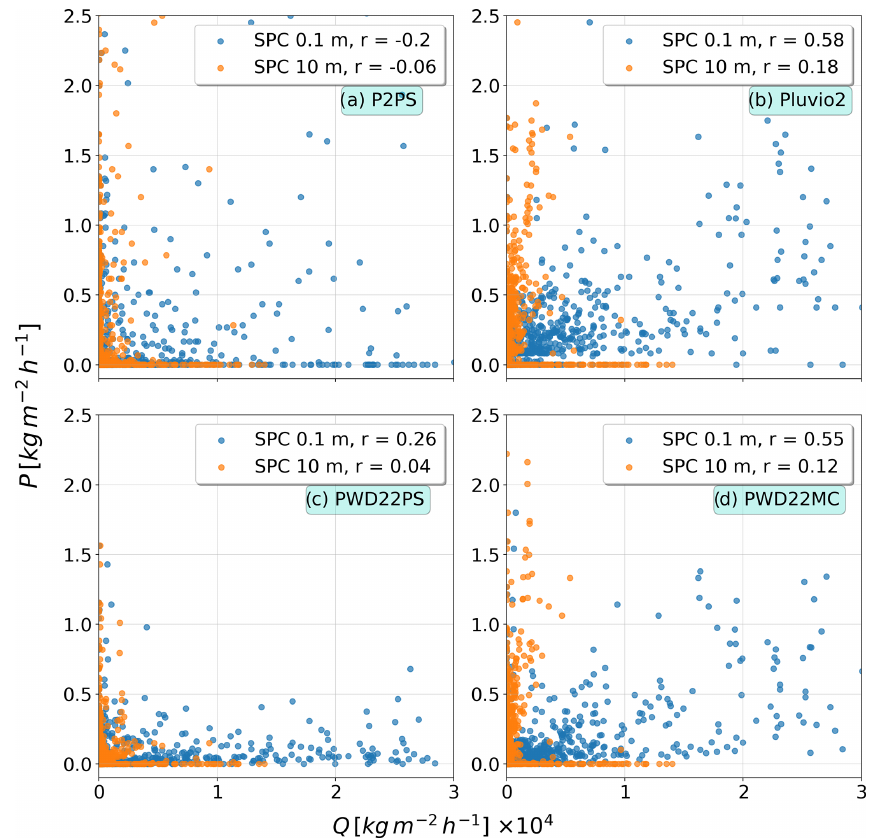
Figure 15. Scatter plots of sensor-computed snowfall rates ( y axes) vs. SPC mass flux ( x axes) for the whole time period for (a) P2PS, (b) Pluvio2, (c) PWD22PS and (d)